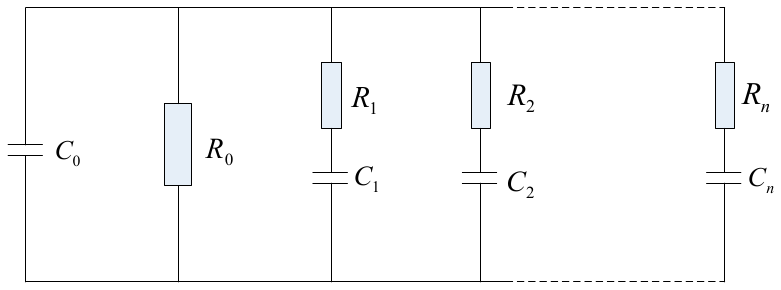
Figure 7. Extended Debye model for transformer oil-paper insulation.